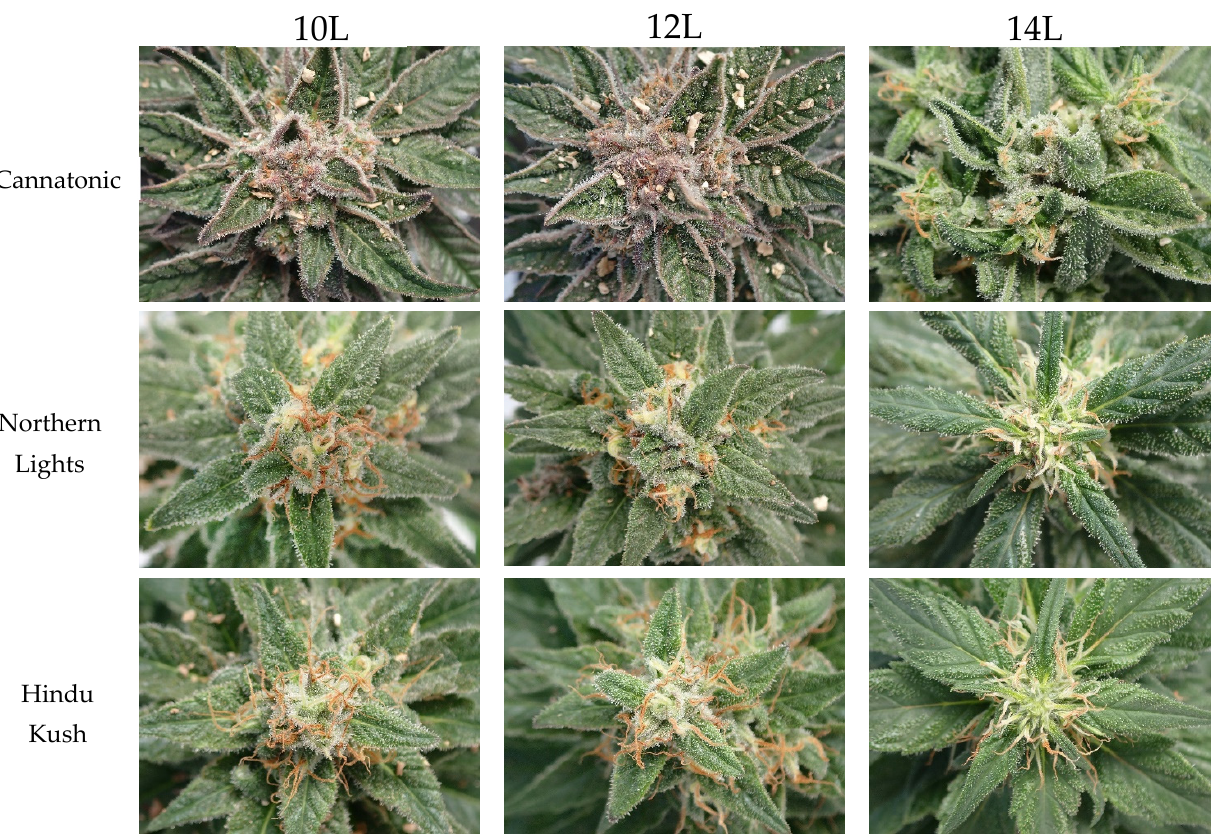
Figure 5. Photographs of the top of the main flowering stem taken at DAC 67 from the three static treatments.